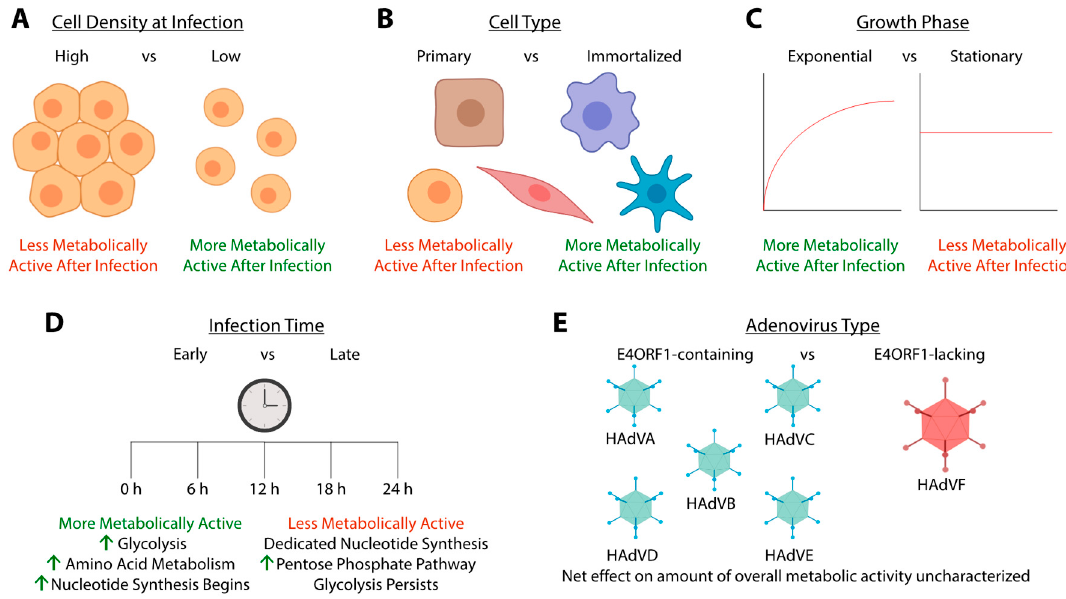
Figure 4. Factors influencing host-cell metabolism with HAdV infection. ( A ) HAdV induced changes in cellular metabolism are less drastic in cells infected at a high cellular density in comparison to cells infected at a low cellular density [31]. ( B ) Cell type can influence the metabolic reprogramming enacted by HAdV. Primary cells are usually slower growing than immortalized cells, which is reflected in a lower metabolic rate. Although metabolism is changed across various cell types upon HAdV infection [31], the rate of that change is likely faster in immortalized cells and contributes to rapid viral replication in immortalized cells [42–44]. However, even among immortalized cells, those with a phenotype more closely resembling the Warburg effect appear primed for HAdV replication and experience more drastic metabolic changes than immortalized cells with a metabolic phenotype reliant on oxidative phosphorylation [45]. ( C ) Growing and dividing cells infected with HAdV show more drastic metabolic changes than infected quiescent cells [46]. ( D ) The metabolic profile of HAdV infected cells changes throughout the course of infection [47]. Initially, HAdV infected cells typically exhibit upregulated glycolysis, amino acid metabolism and nucleotide biosynthesis pathways [47]. Towards the later stages of infection, HAdV infected cells still perform glycolysis, but the majority of metabolic activity is directed towards nucleotide biosynthesis and an upregulation of the pentose phosphate pathway (PPP) occurs [47]. ( E ) Different HAdV types regulate metabolism through mechanisms related to the functions of HAdV E4ORF1 proteins. Some HAdV types (e.g., HAdVF-40) do not have E4ORF1 and clearly rely on other HAdV proteins to regulate metabolism [48]. E1A, which also varies among HAdV types, is another potential regulator of cell metabolism during infection [49–51]. Created with BioRender.